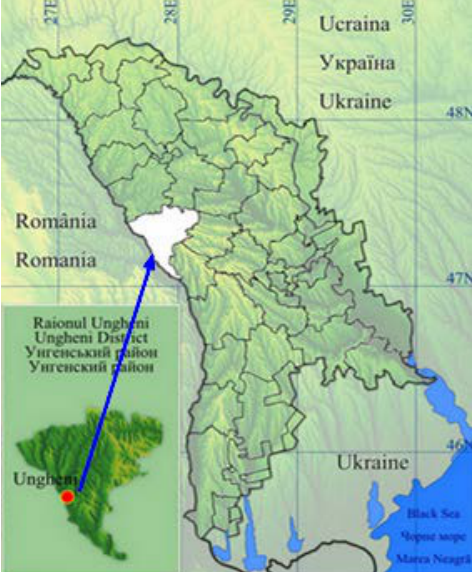
Figure 1. Project area situated on both banks of the transboundary Prut river between Romania (Bosia village) and Republic of Moldova (Ungheni